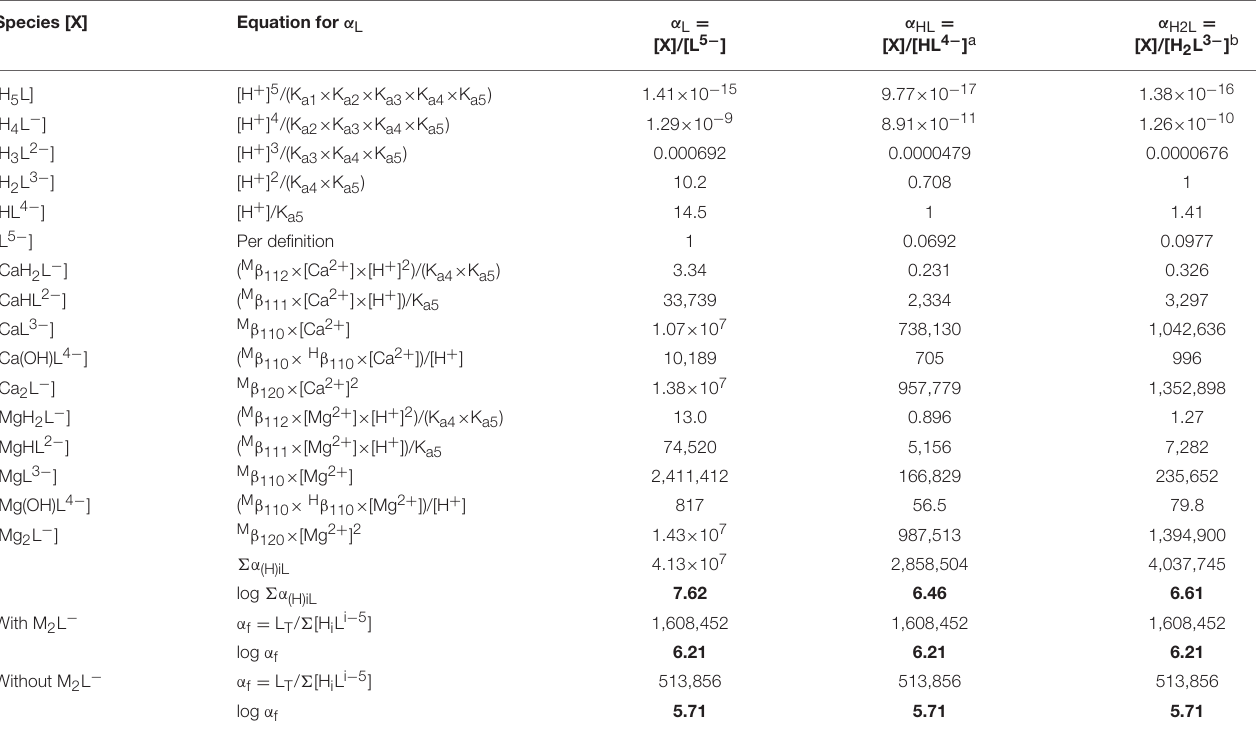
TABLE 8 | Calculation of the side-reaction coefficient in seawater for the three most abundant (de)protonated forms of DTPA, using data from Tables 3 , 7 . Species [X] Equation for α L